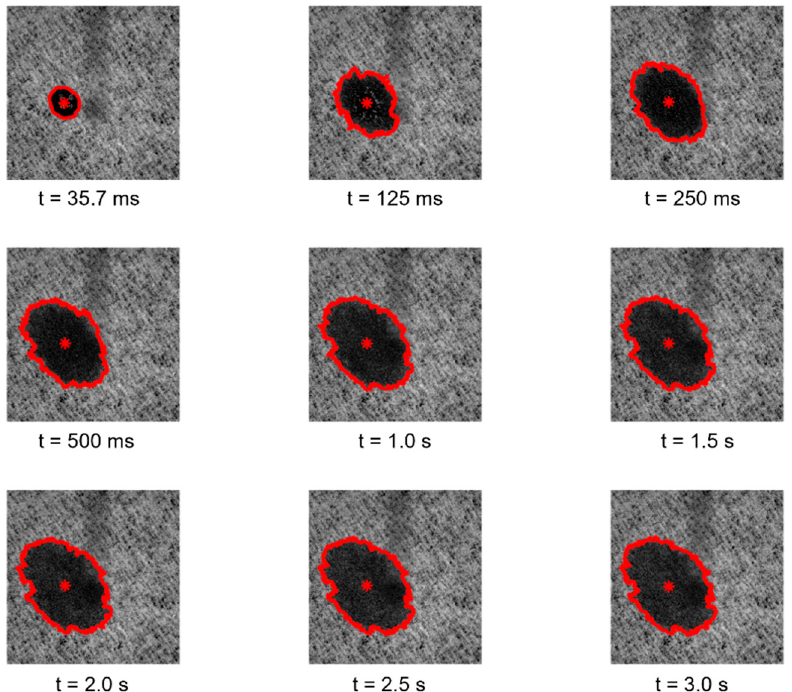
Figure 12. Spreading dynamics of a liquid droplet from t = 35.7 ms to 3 s for the tissue-paper sample Bd rl .